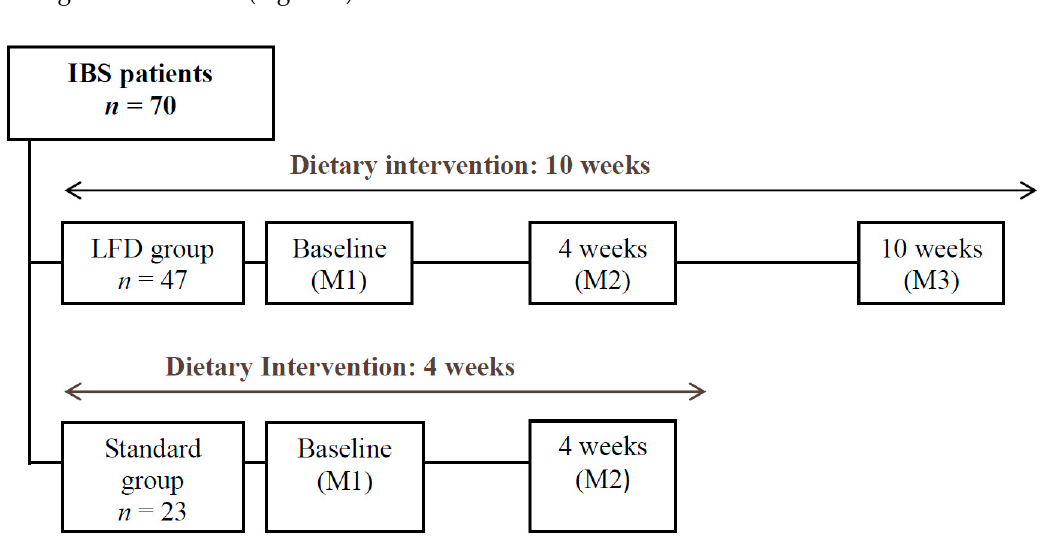
Figure 1. Study Design; M, Moment of Evaluation.